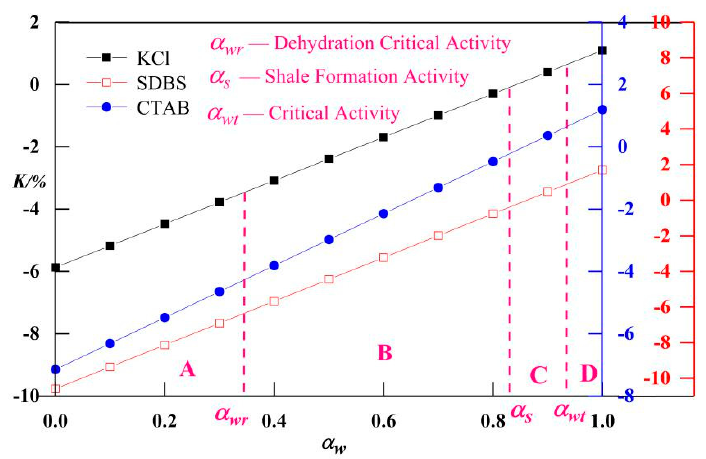
Figure 9. The divisions of the safety levels of drilling fluid Figure 8. The divisions of the safety levels of drilling fluid activity.